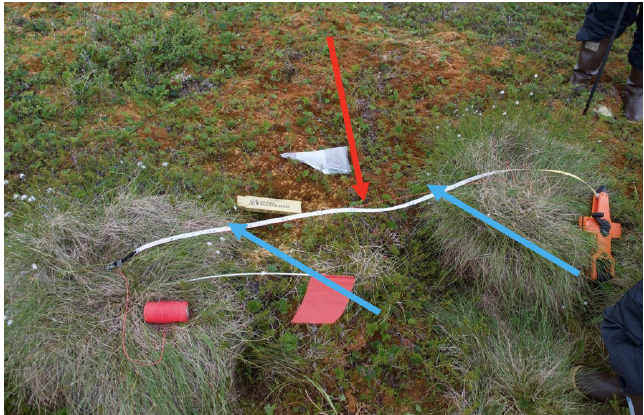
Figure A1. Height measurement of Eriophorum vaginatum in an unburned area from the taut string (red arrow) to the dense vegetation layer between the starting and ending points (blue arrows) at the edge of each tussock patch.